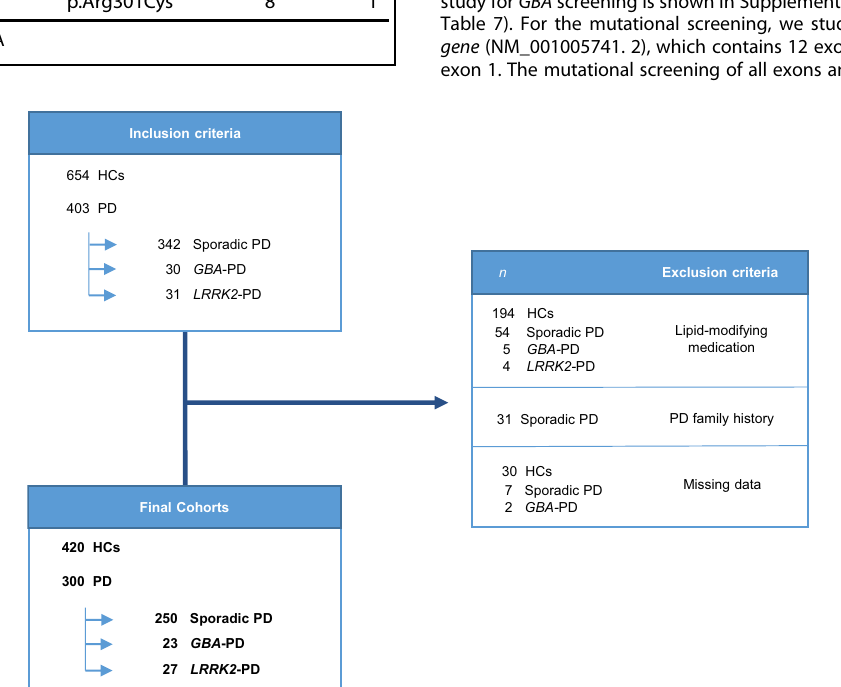
Fig. 2 Study fl owchart with selection criteria and fi nal cohorts. HCs healthy controls, GBA -PD GBA- associated Parkinson ’ s disease patients, LRRK2 -PD LRRK2 -associated Parkinson ’ s disease patients, PD Parkinson ’ s